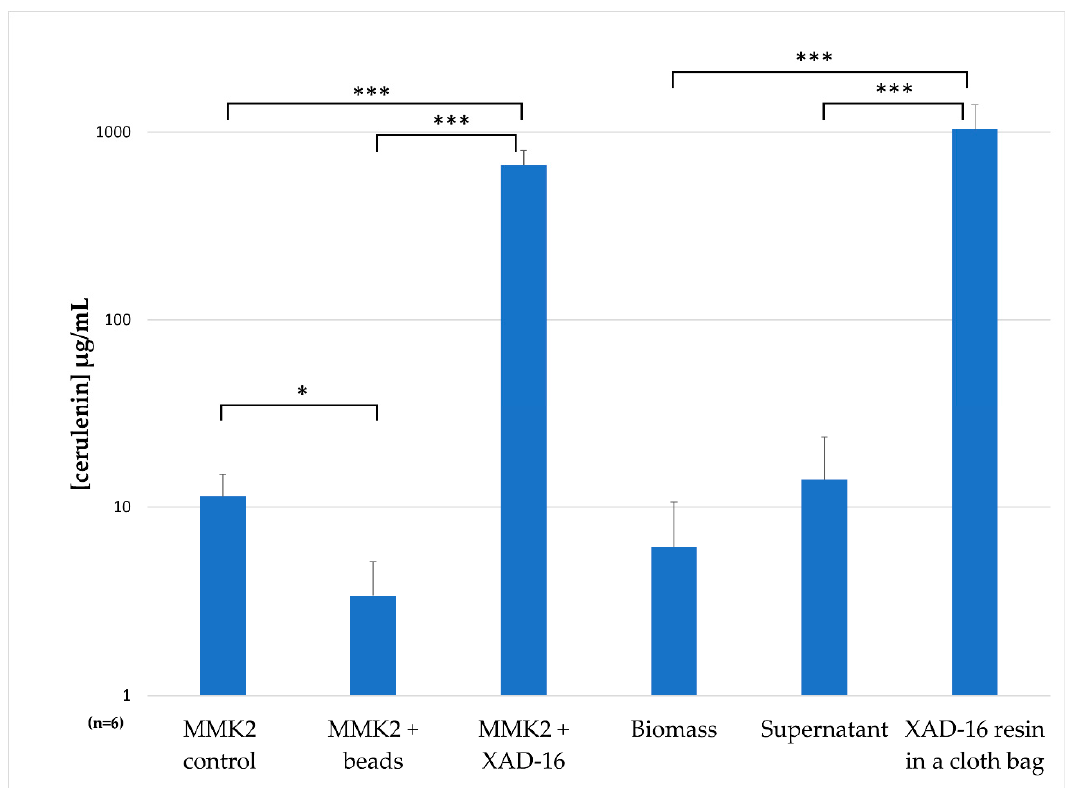
Figure 8. Cerulenin yield production in µg/mL by interpolation of UV area at 210 nm for each fermentation condition tested for the D. tragani CF-090383 fungal strain (x ̅ ± SD; n = 6; significant differences calculated by t - test).